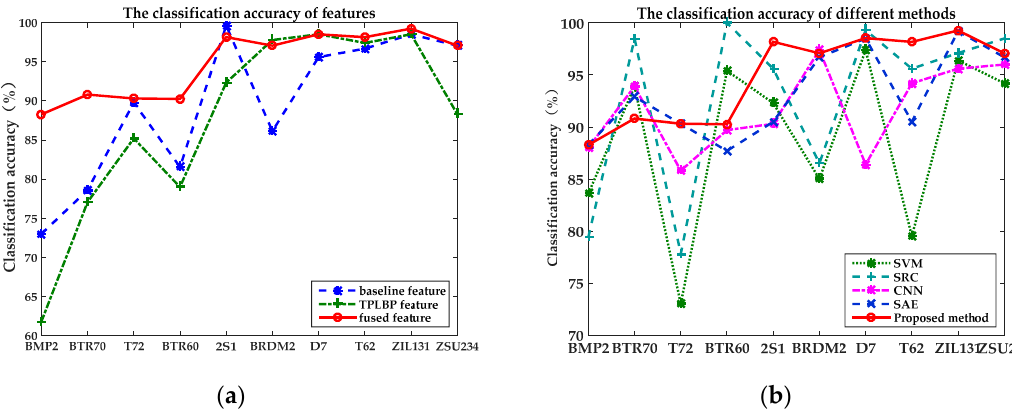
Figure 9. The classification accuracy of 10-class targets. ( a ) Comparison of the classification accuracy of baseline features, TPLBP features and fused features on 10-class targets; ( b ) Comparison of the classification accuracy of different method including SVM, SRC, CNN, SAE and the proposed method.